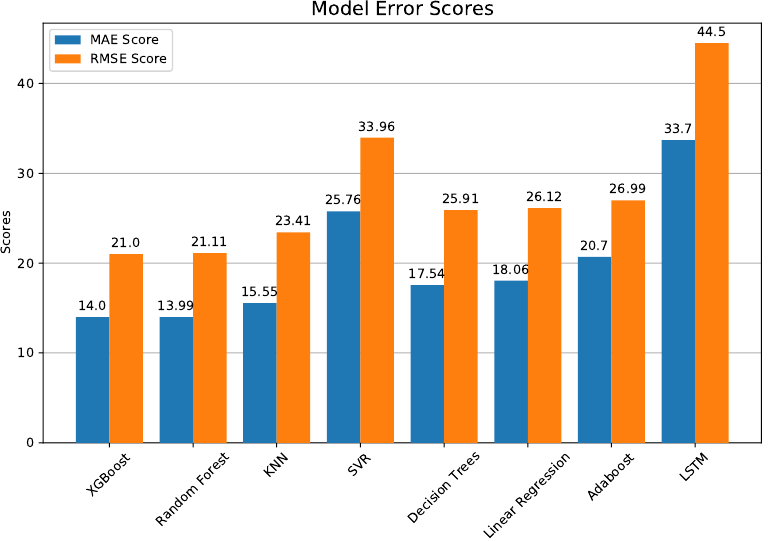
Figure 11. Same as Figure 10 but for annual model error scores of MAE and RMSE. Both are in units of µ g/m 3